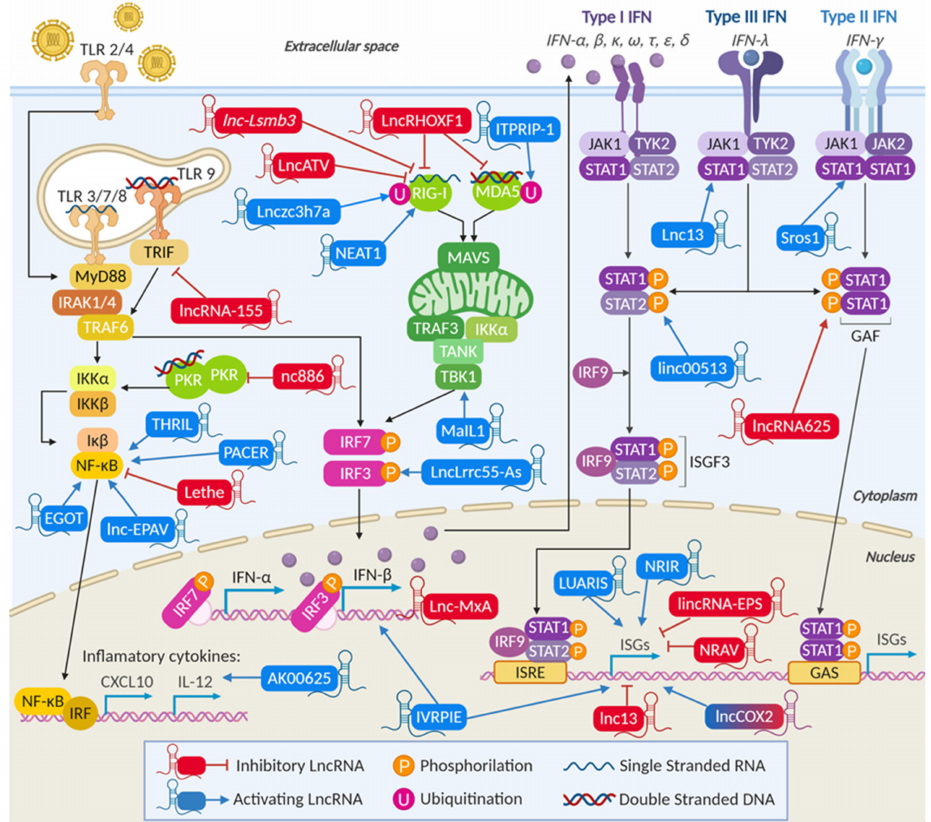
Figure 3. LncRNAs a ff ect many steps of the interferon (IFN) synthesis (left) and signaling pathways (right). See text for details. LncRNA-linked blue arrows depict activation while red arrows indicate inhibition. Name frames are in blue for activating lncRNAs, red for inhibitory lncRNAs, and in both colors for lncRNAs with dual